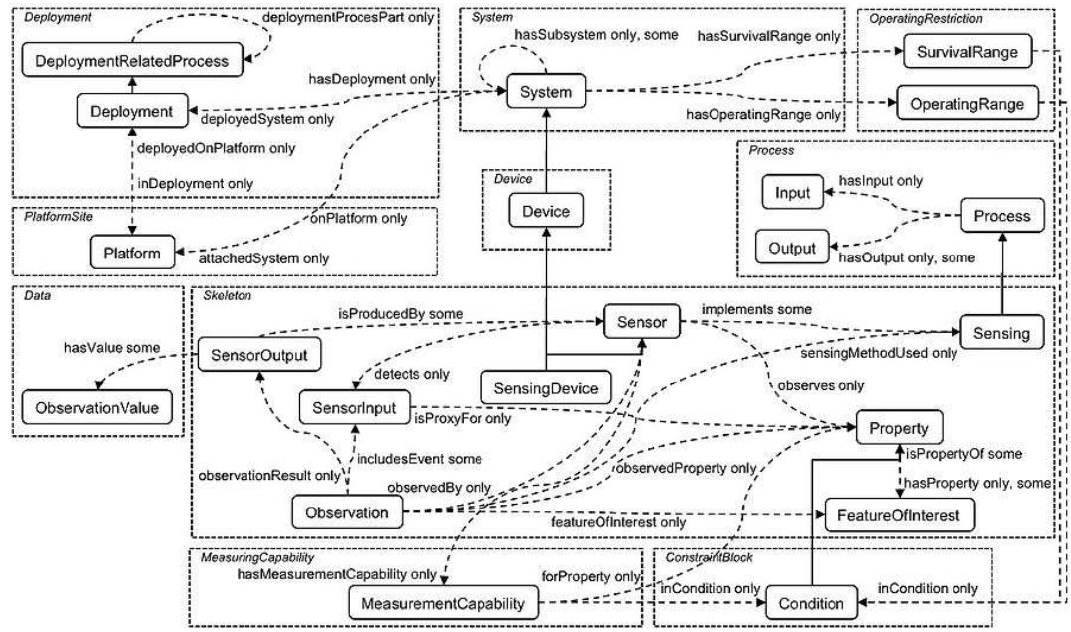
Figure 4. The Semantic Sensor Network (SSN)